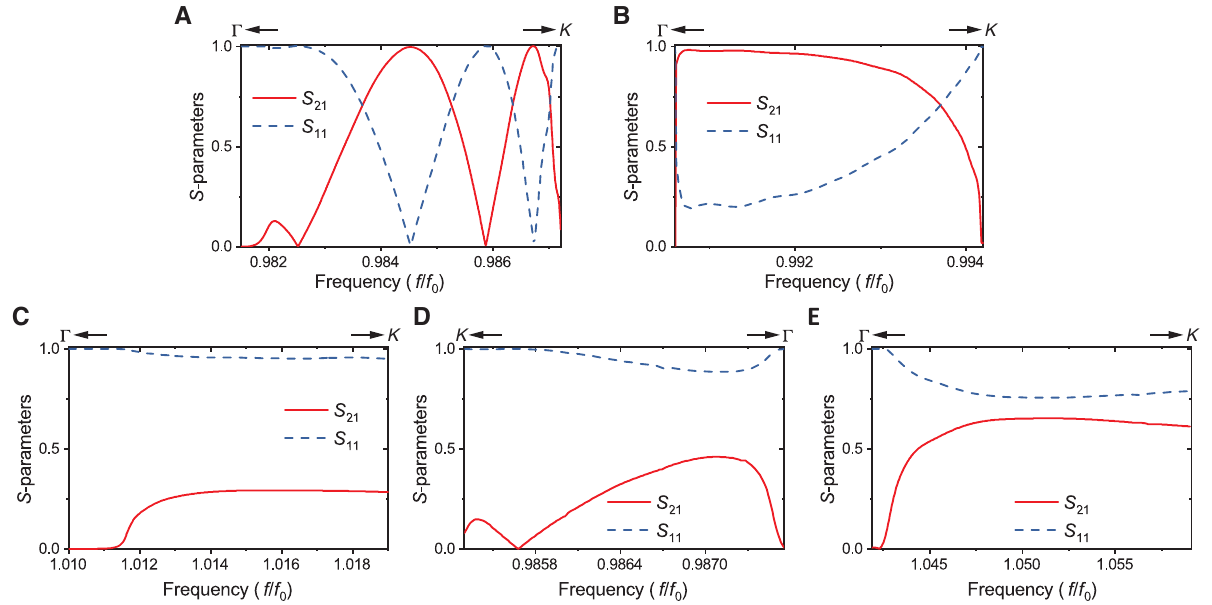
Figure 5: The extracted S parameters for the 60 degrees sharp turn. Spectrum for (A) the armchair and (B) zigzag interfaces of the C6-symmetry-based waveguide, (C) bridge, (D) armchair and (E) zigzag interface of the VH-based PTI waveguide. The extracted S